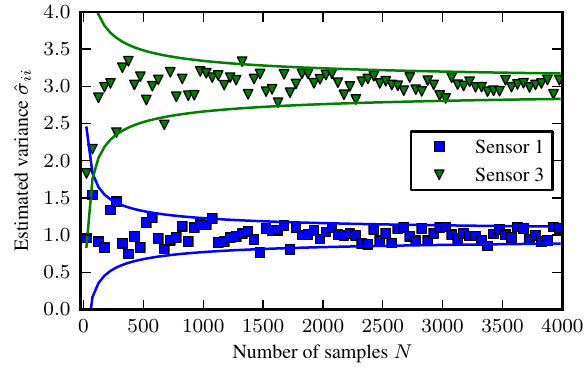
Fig. 1. Exemplary time series with N = 60 , generated by the ap- proach described in Sect. 6.